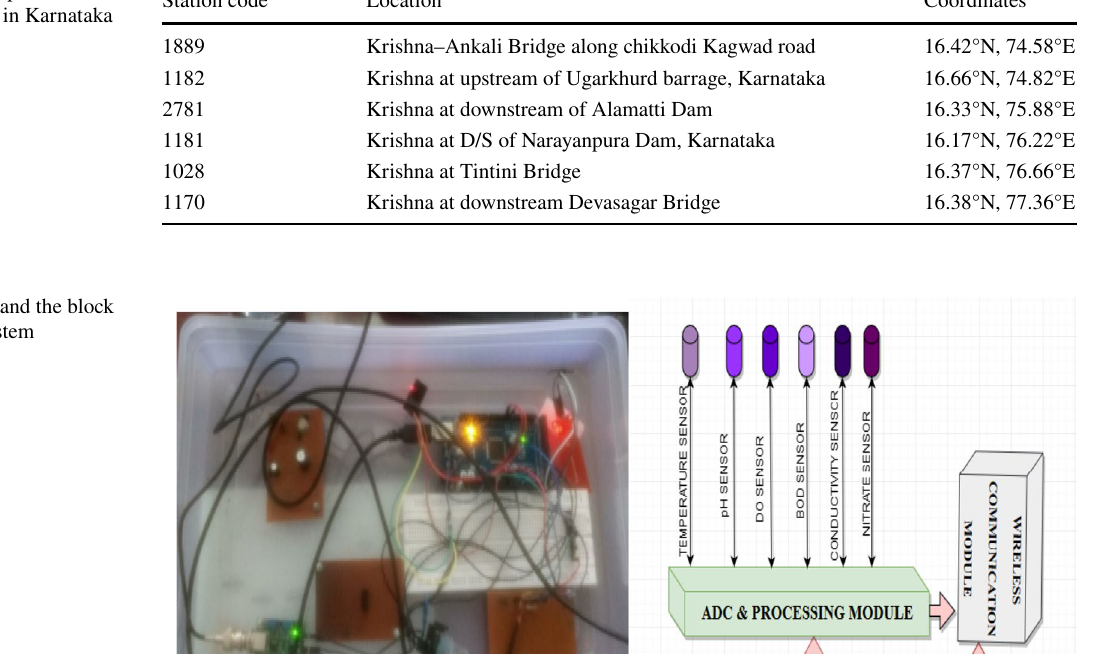
collection stations in Karnataka